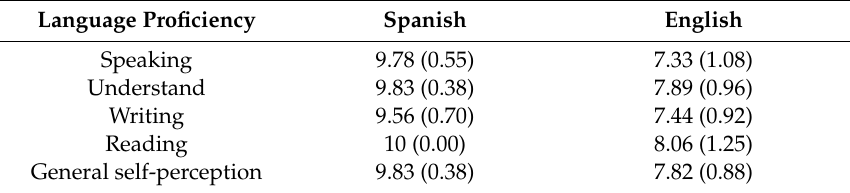
Table 3. Experiment 2: Mean levels of Spanish and English language proficiency calculated by participant’s self-perceived ratings. Standard deviations are provided within